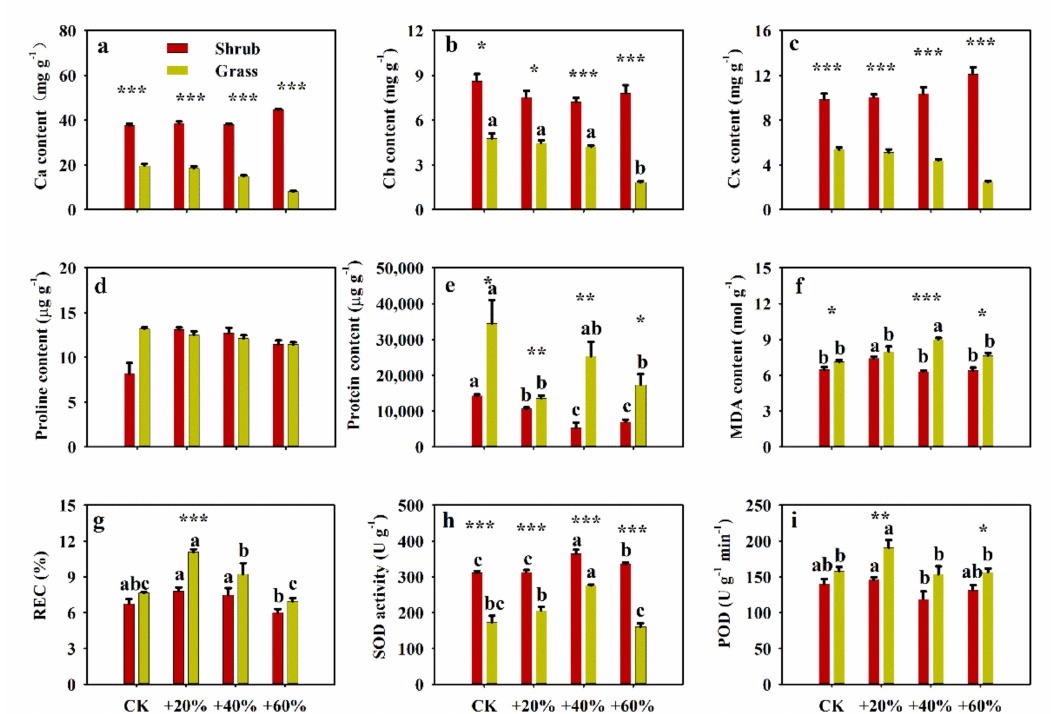
Figure 2. E ff ects of experimentally-increased precipitation on biochemical traits of Stipa glareosa in the Inner Mongolian desert steppe. ( a ) Chlorophyll a (Ca) content, ( b ) chlorophyll b (Cb) content, ( c ) carotenoids (Cx) content, ( d ) proline content, ( e ) protein content, ( f ) malondialaenyde (MDA) content, ( g ) relative electrical conductivity (REC), ( h ) superoxide dismutase (SOD) activity and ( i ) peroxidase (POD) activity. Di ff erent lower-case letters indicate significant di ff erences ( p < 0.05) between treatments for the same vegetation type. Asterisk represents significant di ff erences between di ff erent vegetation types, *: p < 0.05, **: p < 0.01, ***: p <